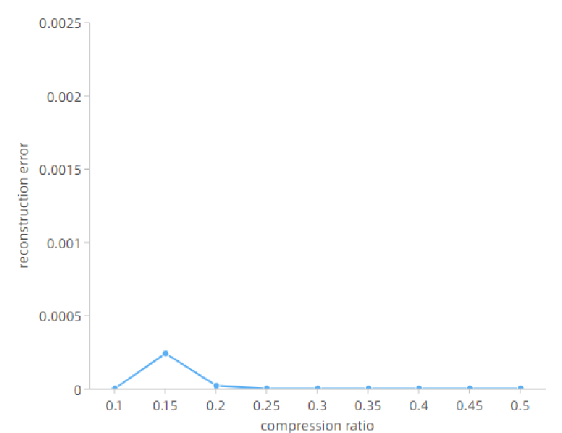
. Fig. 4. Reconstruction error of